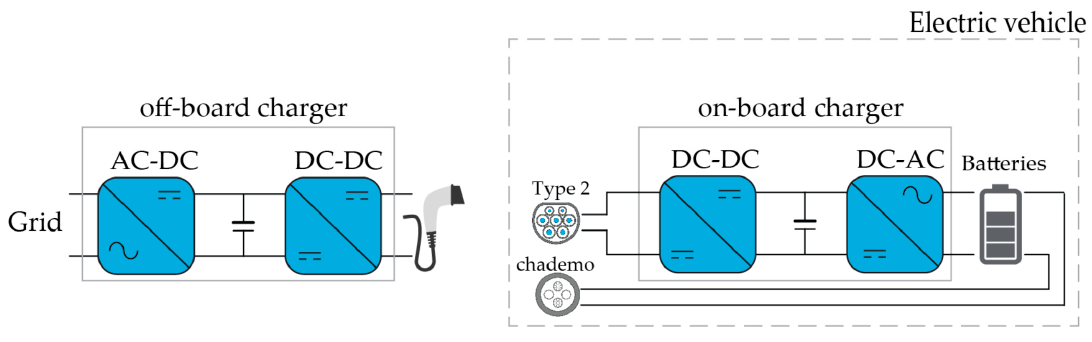
ff -board and on-board chargers for an electrical vehicle Figure 1. Off-board and on-board chargers for an electrical vehicle (EV). Figure 1. O